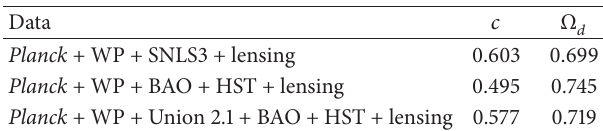
Table 3: Planck data sets.